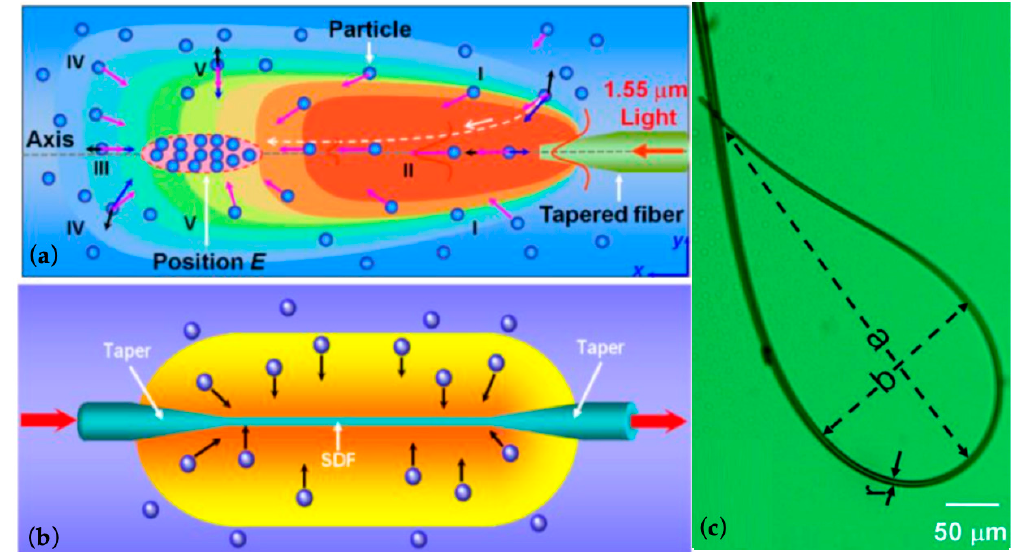
Figure 16. Massive photothermal trapping and assembly of particles using ( a ) tapered optical fiber [75], ( b ) subwavelength diameter optical fiber [76], and ( c ) optical fiber ring [77].